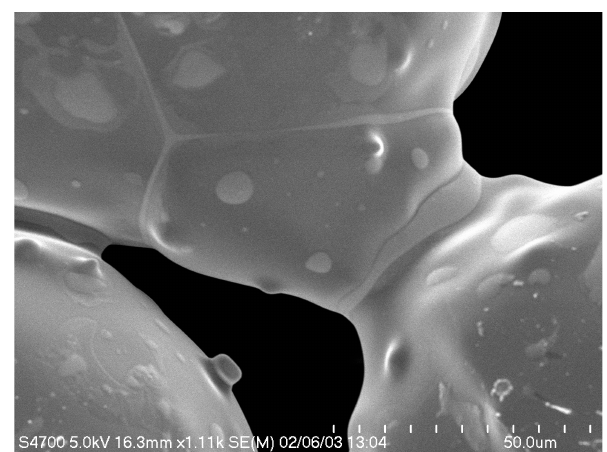
Fig. 6. Low temperature scanning electron microscopy image of ice particles containing salt. The lighter-grey regions along grain boundaries and as isolated patches are NaCl · 2H 2 O. The darker- grey areas show ice. Reprinted with permission from Blackford et al.